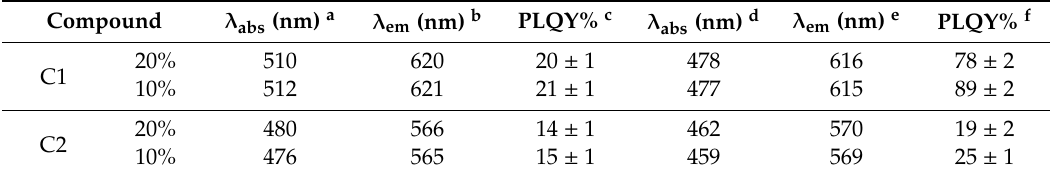
Table 2. Optical data for C1 and C2 neat solids and in polystyrene (PS) and polyvinylcarbazole (PVK)